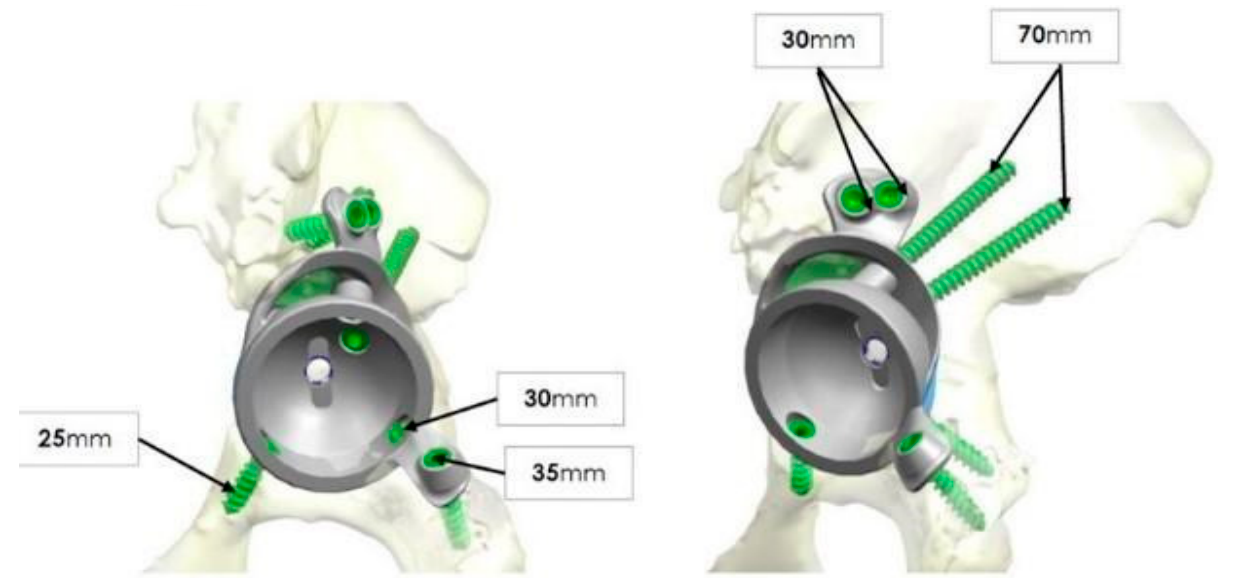
Figure 4. Design proposal of the 3D custom-made acetabular cup.